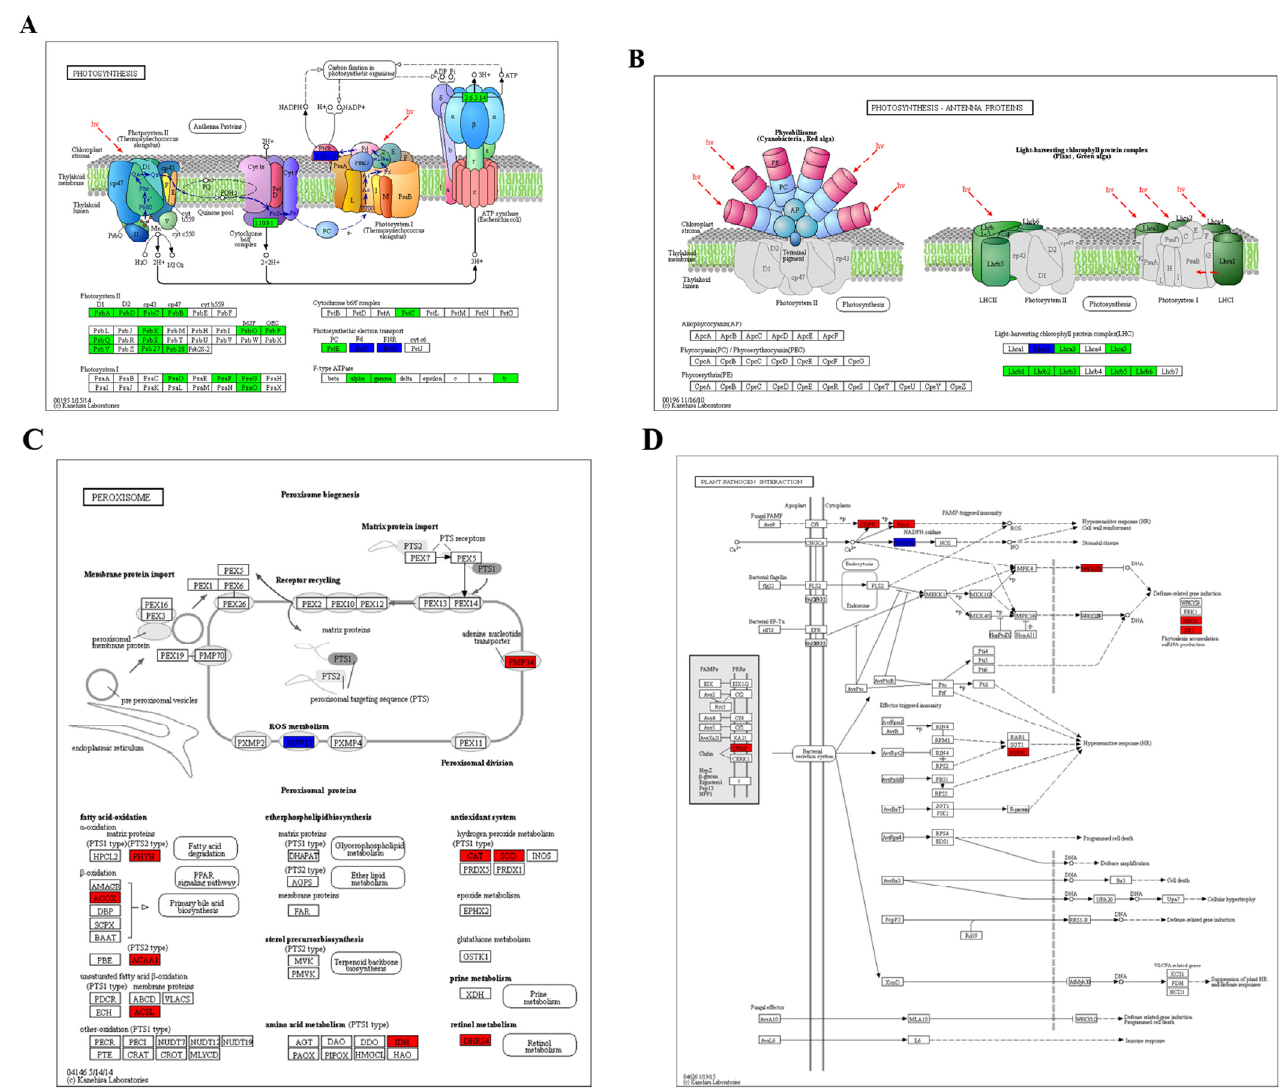
Figure A3. Differential map of genes in different pathways between wild type and spl42 mutant. ( A ) Differential genes in photosynthesis pathway. ( B ) Differential gene of photosynthesis-antenna protein. ( C ) Differential genes of the peroxisome pathway. ( D ) Differential genes for the interaction between plants and pathogens.